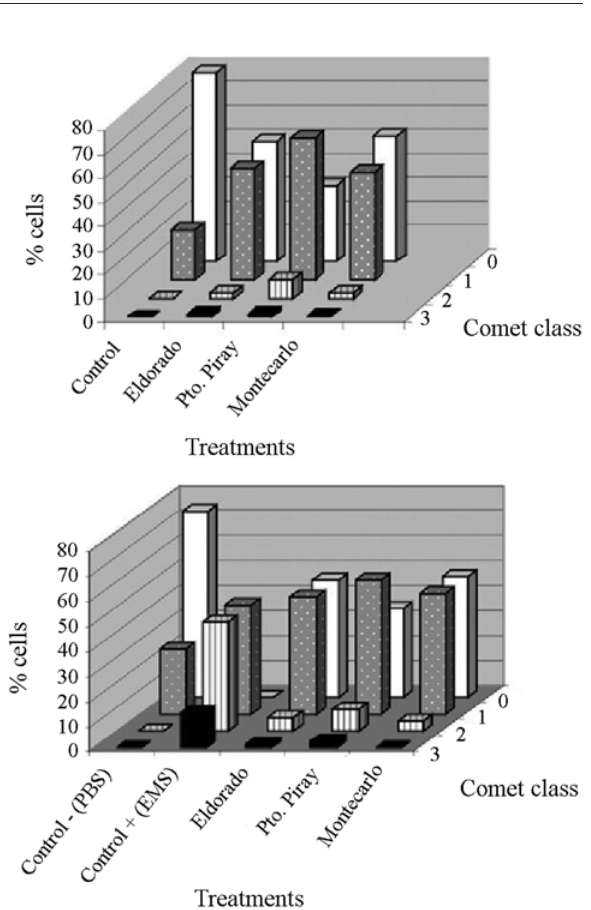
Figure 2 - Levels of DNA damage in (a) Corbicula fluminea hemolymph cells and (b) Chinese hamster K1 (CHO-K1) cells after treatment with Paraná River